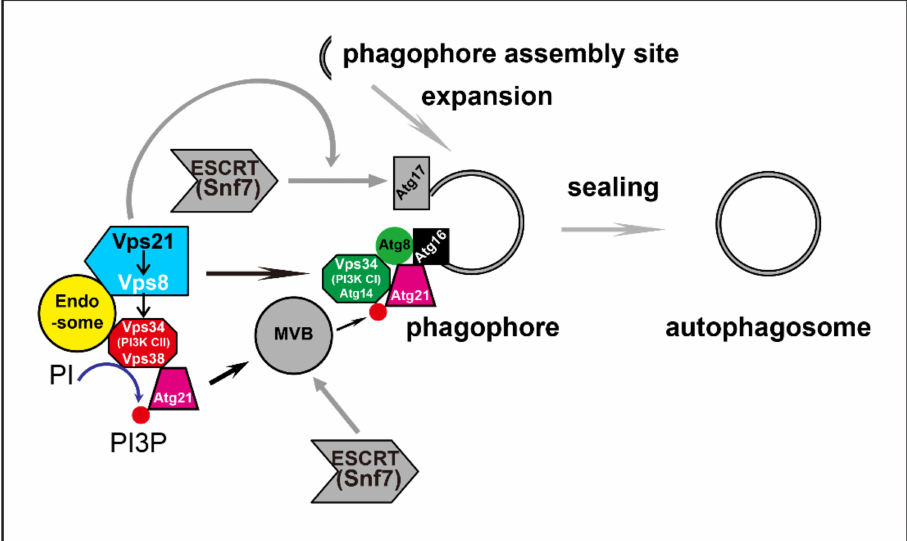
Figure 9. Proposed model of the roles of Vps21 in autophagy through regulating PI3K complexes and subsequent interactions. Vps21 controls the interaction between Vps8 and Vps34 and their localizations to endosomes. Vps21 further regulates the subsequent interactions between Vps34 and Atg21, Atg21 and Atg16, and Atg21 and Atg8 and the locations of these interactions. Defects in these localizations and/or interactions might impair the roles of Vps21 in progressing autophagy in the early stage. In addition, during the late stage, Vps21 regulates autophagosome closure by recruiting ESCRT via Snf7-Atg17 interaction [22,34]. Arrows and graphic symbols in gray color indicate published